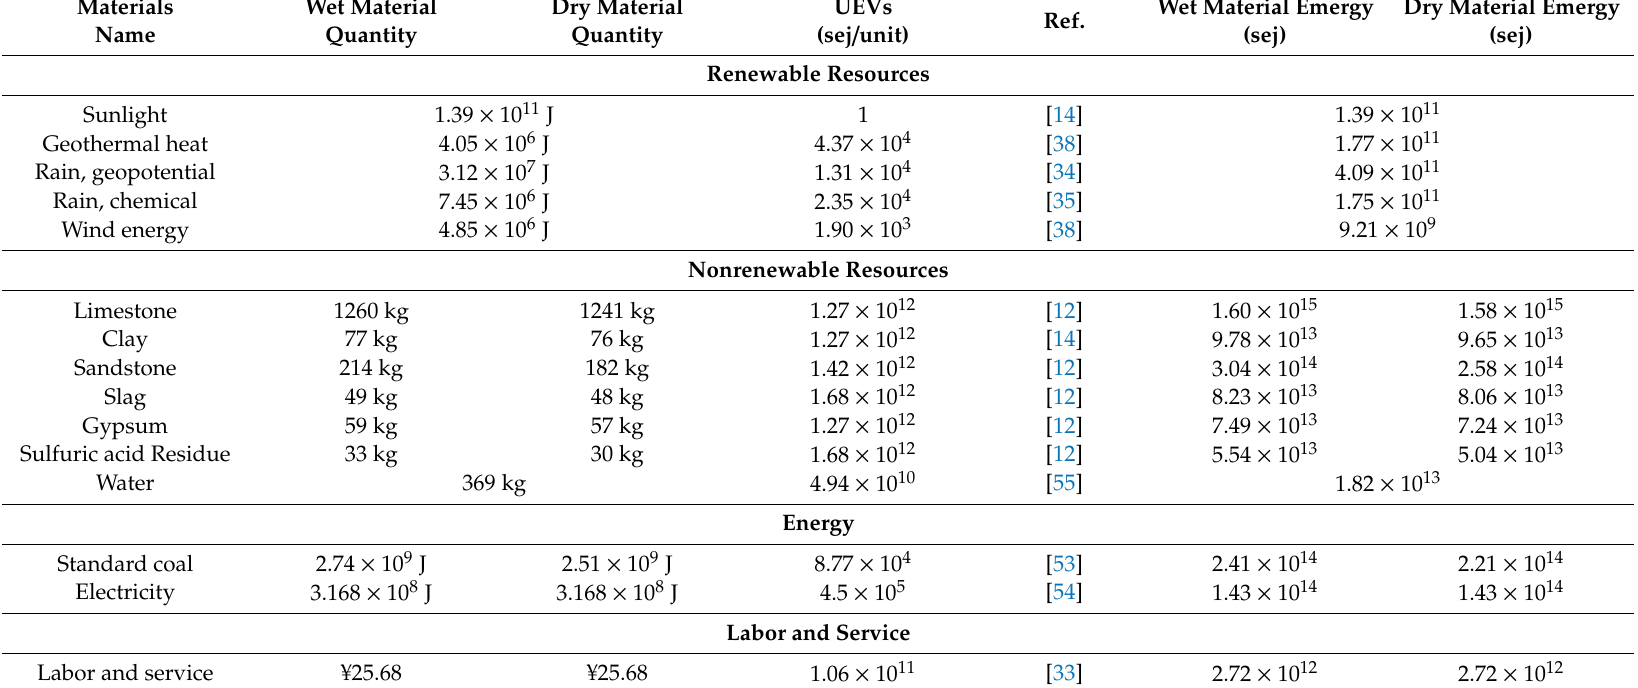
Table 18. Emergy calculation of the cement products based on the total